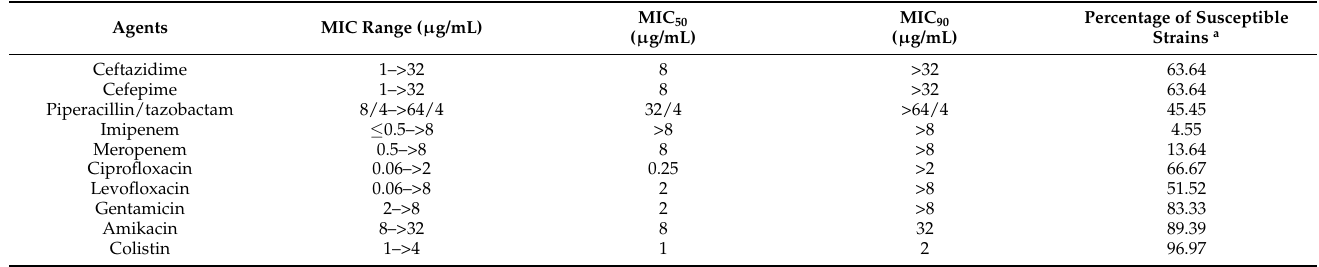
Table 1. In vitro susceptibility and percentage of susceptibility among ceftolozane/tazobactam (C/T) and comparator agents against clinical isolates ( n = 66) of carbapenem-resistant Pseudomonas aeruginosa (CRPA) from the broth micro dilution